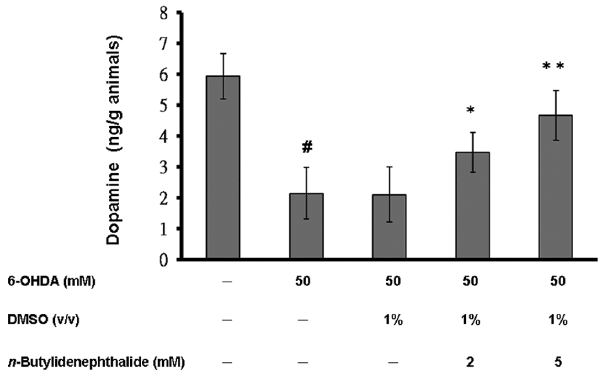
Figure 7. n -Butylidenephthalide raises DA content in 6-OHDA- treated N2 C.elegans . Shown is quantitation of DA levels (ng/g wet weight of animals) by HPLC-chemiluminescence detection in 6-OHDA- untreated animals, 6-OHDA-treated animals, or n -butylidenephthalide/ 6-OHDA-treated animals. Three-day-old animals synchronized for age were used. The data represent the mean 6 SD (n=3). A hash ( # ) indicates significant differences between 6-OHDA-treated and untreat- ed animals ( p , 0.001); an asterisk (*) indicates significant differences between the 6-OHDA-treated control samples and the n -butylide- nephthalide/6-OHDA-treated samples (* p , 0.05, ** p , 0.01).